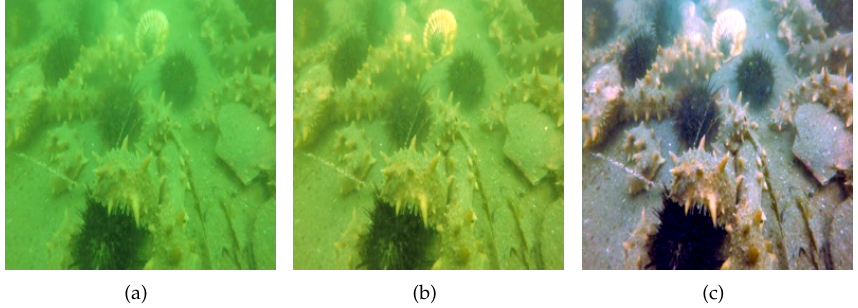
Figure 2. Example of unsuccessful preliminary recovery result and the final adaptive color correction result. ( a ) the original image; ( b ) preliminary recovery result; ( c ) adaptive color correction result produced by the proposed